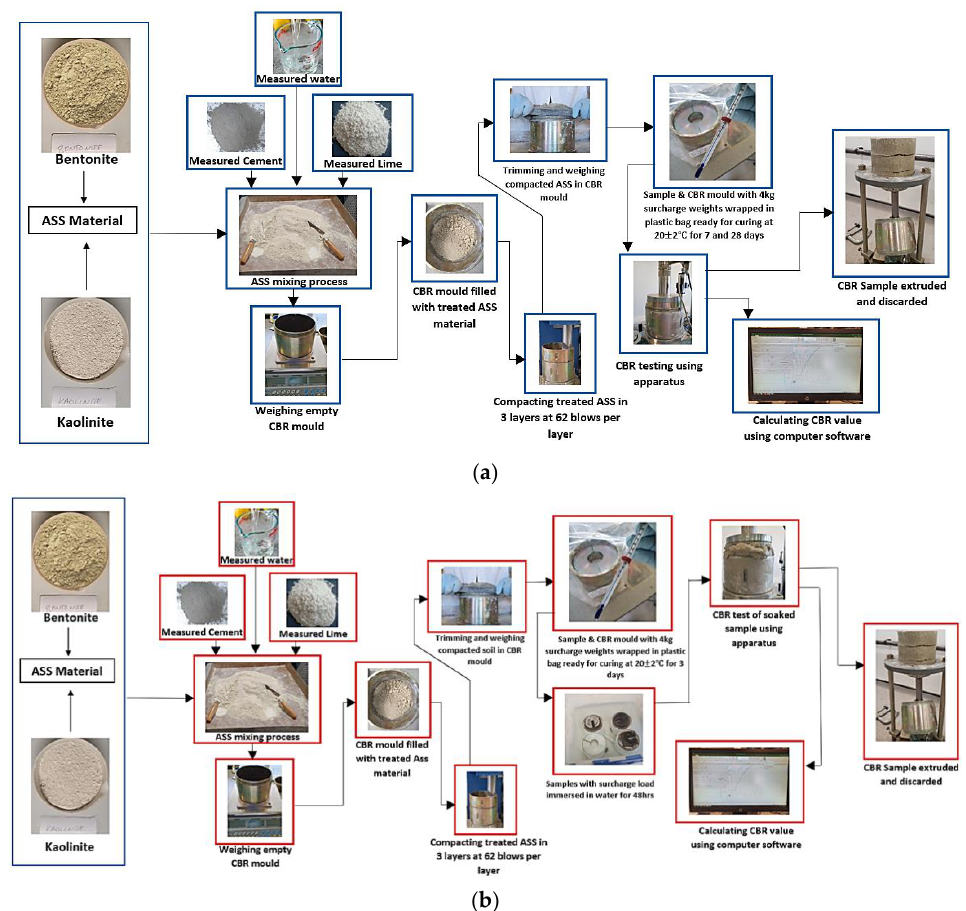
Figure 4. ( a ) The mixing and testing process of the treated-unsoaked CBR samples; ( b ) the mixing and testing process of the treated-soaked CBR samples .